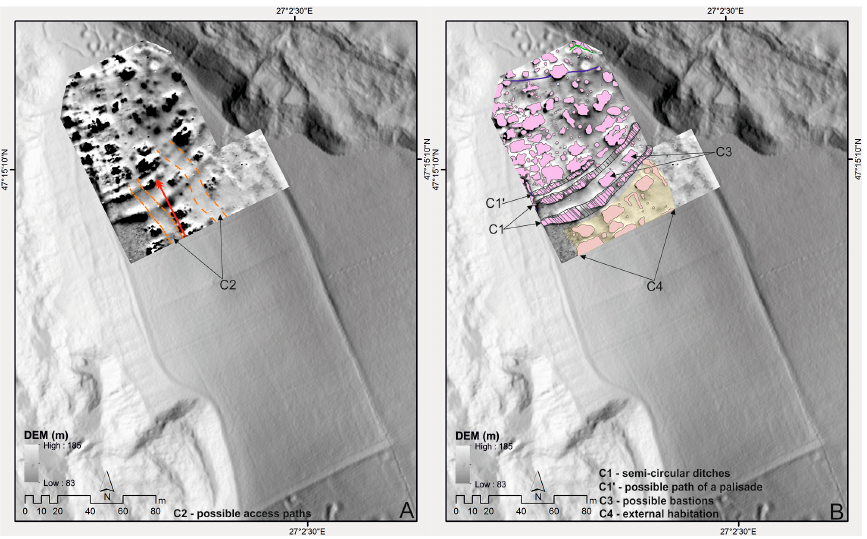
Figure 11. Interpreting the anomalies identified by total field measurements: ( A ) Magnetic map ( − 15 to +15 nT, white to black) overlaid on the DEM from ALS; ( B ) Anomalies identified.